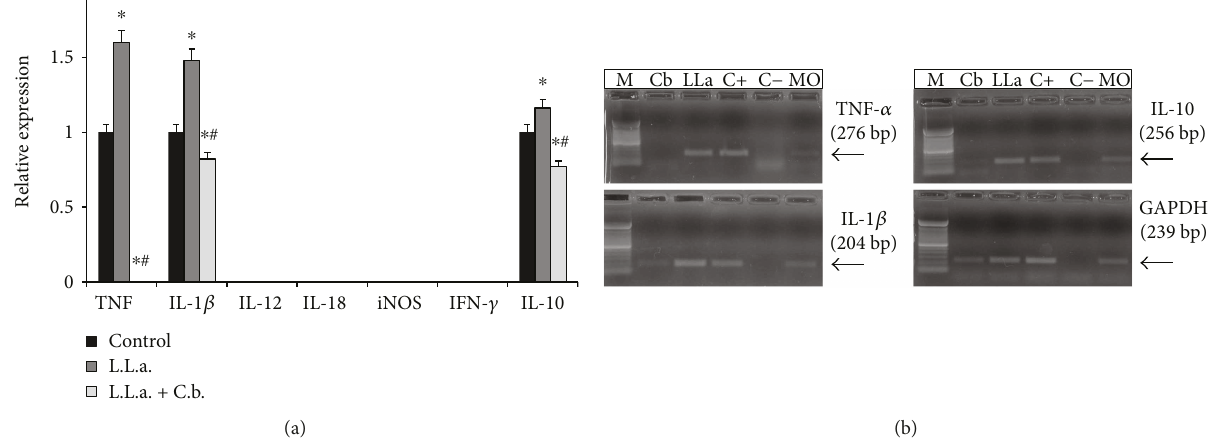
Figure 2: Expression levels of cytokines and iNOS mRNA by macrophages infected with L. ( L. ) amazonensis or treated with hydroalcoholic extract of C. brasiliense . (a) L.L.a: L. ( L. ) amazonensis ; C.b.: C. brasiliense . L.L.a+ C.b.: peritoneal macrophages from BALB/c mice were infected with promastigotes of L. ( L. ) amazonensis (10 parasites :1 macrophage) for 3h and then treated with hydroalcoholic extract of C. brasiliense (30 μ g/ml) for 3h; L.L.a.: macrophages infected and untreated; control: macrophages uninfected and untreated were incubated only with RPMI during 6 h (negative control) ∗ p < 0 05 signi fi cantly compared with negative control; # p < 0 05 compared to infected macrophages. (b) In 1.5% agarose gel electrophoresis, the products of reverse transcriptase-polymerase chain reaction for conditions above were revealed with ethidium bromide in a transilluminator. M: molecular marker; C − : ampli fi cation negative control (H obtained from macrophages stimulated with 5 μ g/mL of lipopolysaccharide (LPS); MO: macrophages (negative control, uninfected and untreated); Cb: macrophages treated with C. brasiliense ; LLa: macrophages infected with L. ( L. ) amazonensis